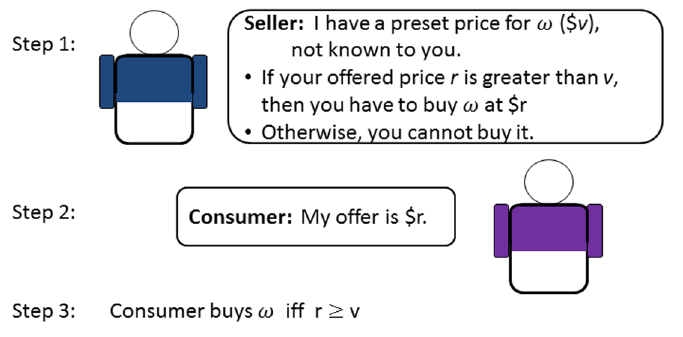
Fig 2. The Becker-DeGroot-Marschak